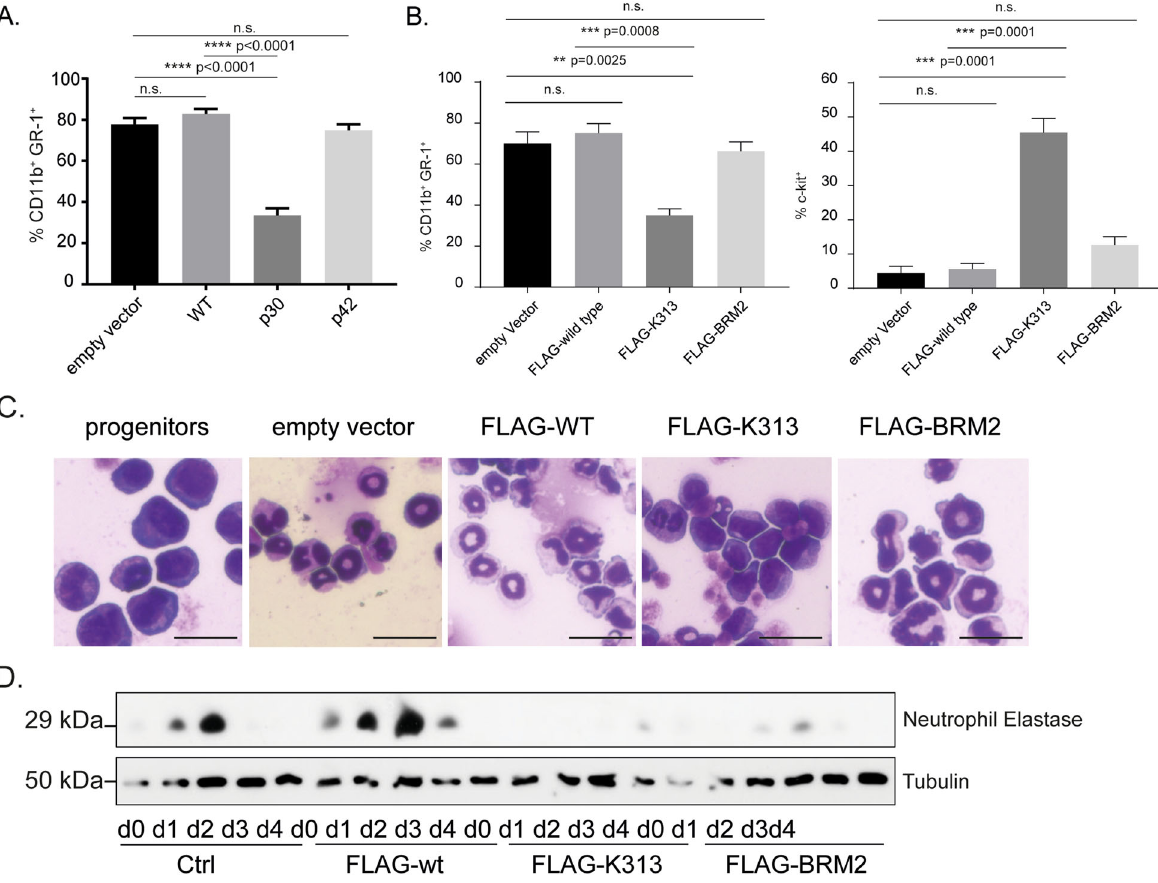
Fig. 1 Overexpression of mutant C/EBP α can block differentiation of HoxB8-immortalised neutrophil progenitors in vitro. A Quanti fi cation of Gr-1/CD11b double-positive populations during differentiation of wt progenitor cells expressing untagged C/EBP α − wt, C/EBP α -p30, or C/EBP α -p42. Quanti fi cations show mean and SEM of at least three independent experiments. P values were calculated using one-way ANOVA with multiple comparisons. B Quanti fi cation of Gr-1/CD11b double-positive and of c-Kit positive populations